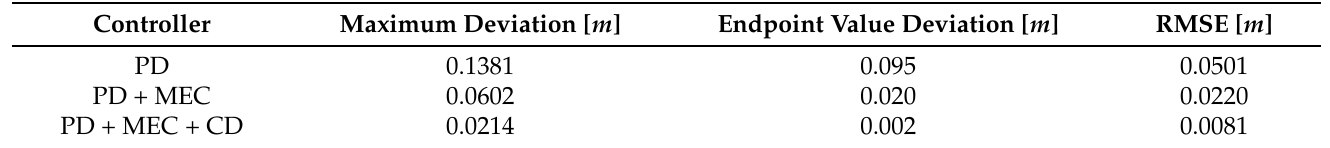
Table 1. Quantitative comparison of quadruped-CoM tracking with three controllers.